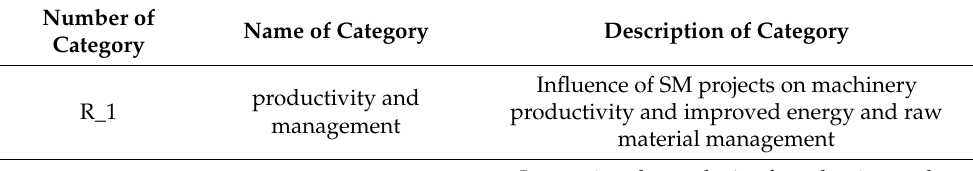
Table 1. Categories of influence the SM projects on business